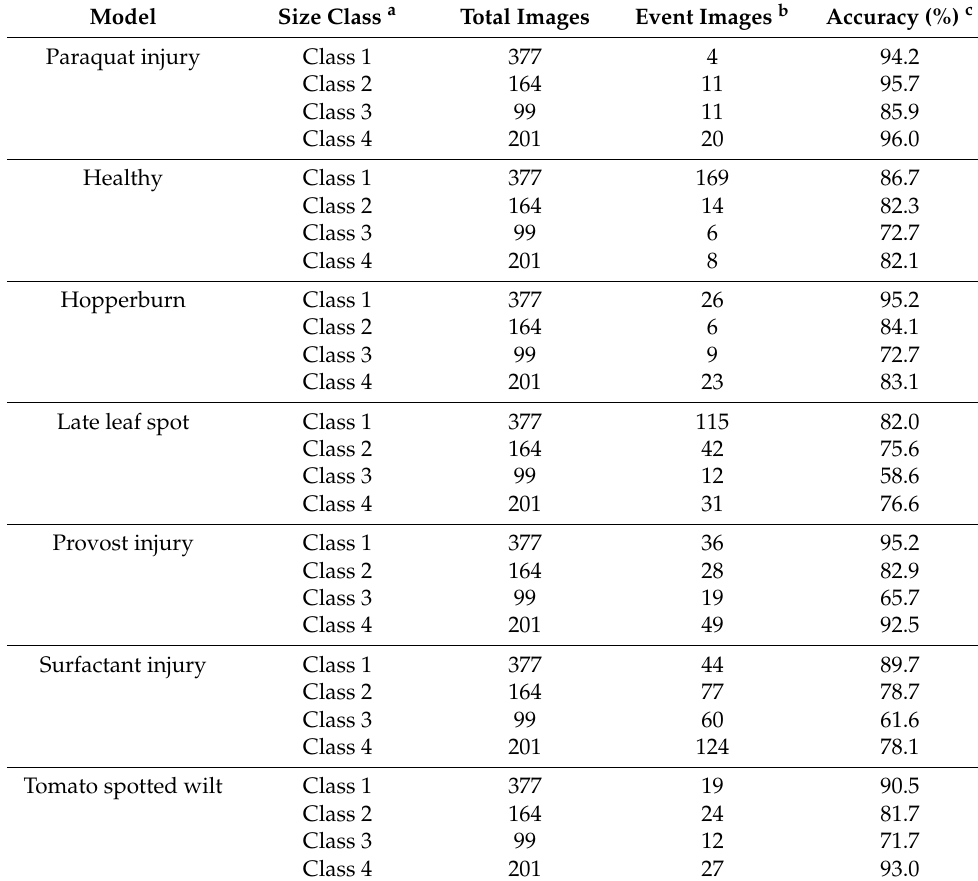
Table 3. The total number of images, the number of event images and the accuracy of each pixel size class by